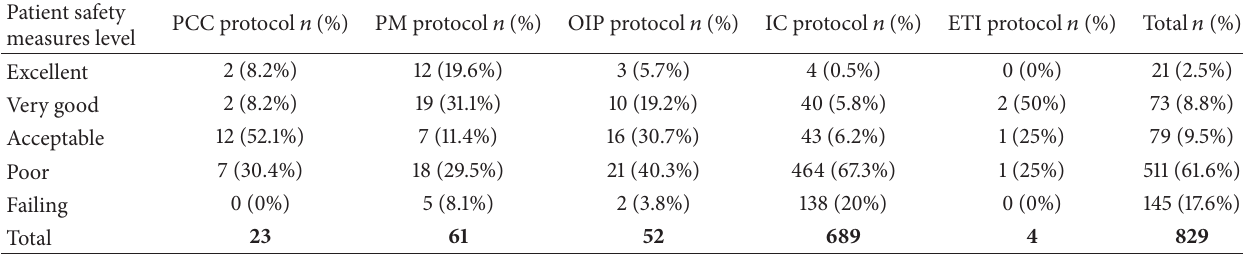
Table 2: Level of observed application of patient safety measures recommended for common procedures in the ICU. Patient